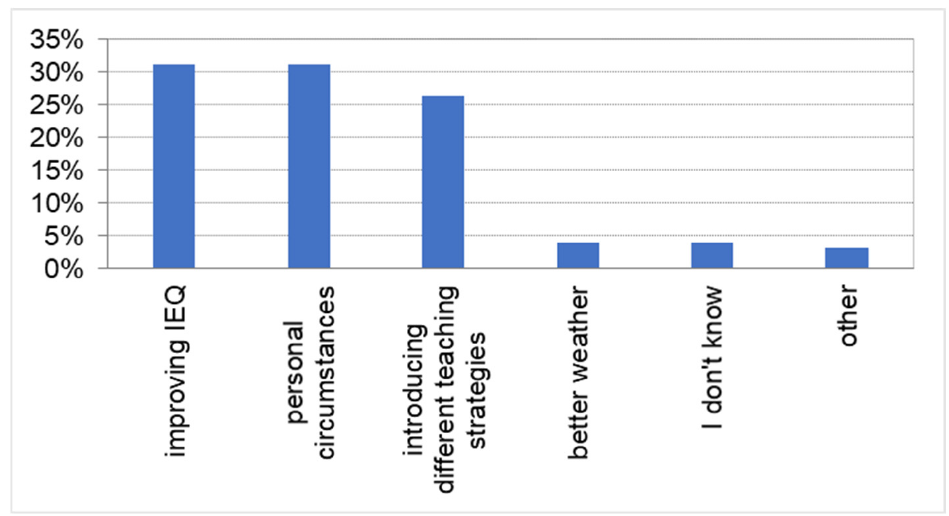
Figure 11. Subjective factors affecting the willingness to work defined by students. Figure 12 shows the percentage distribution of students’ perceptions and feelings com- piled for all test days. The answer ’yes’ is marked in blue and was chosen when discomfort occurred; ‘no’—is coloured orange, when the students did not report any aliments. Most of the respondents, about 63%, complained of drowsiness and 54% of general fa- tigue; 44% confirmed problems with concentration and 31% with visual acuity. Headaches were reported by